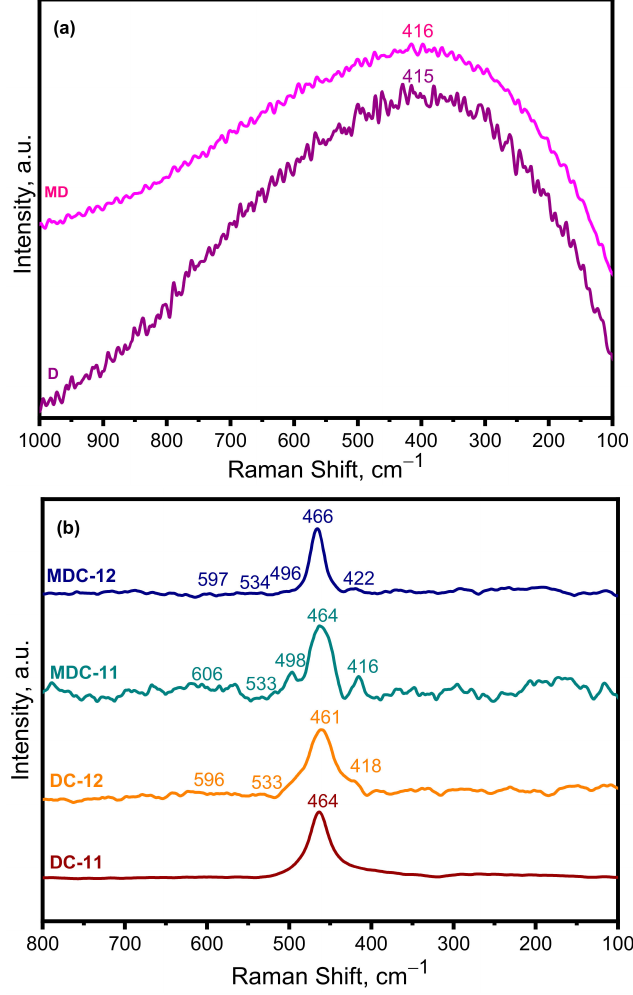
Figure 2. Raman spectra of ( a ) D, MD, ( b ) DC-11, DC-12, MDC-11, and